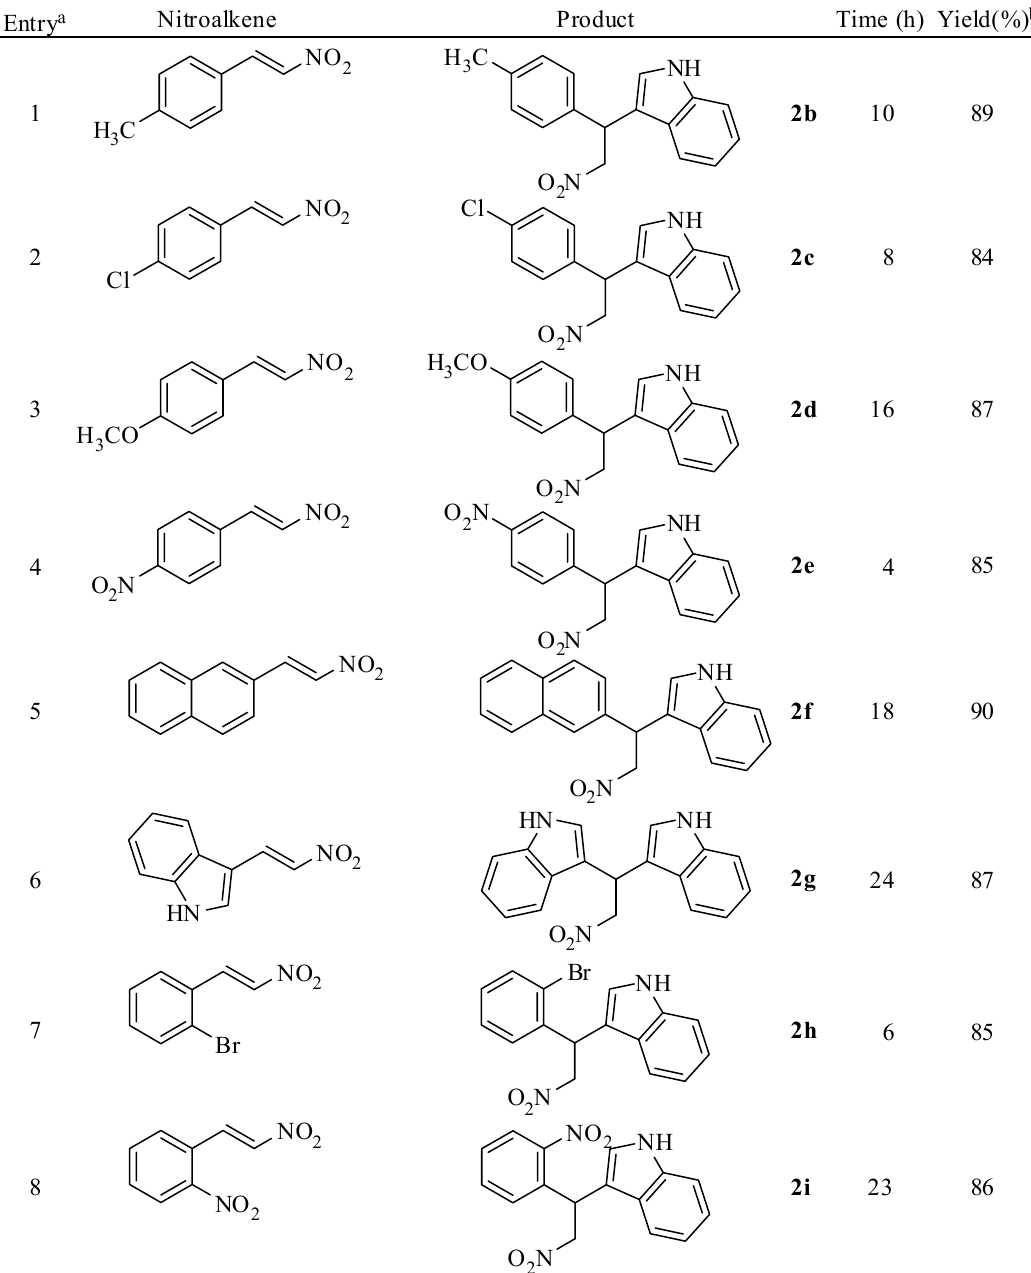
Table 2. Synthesis of indolyl-nitroalkane derivatives from various